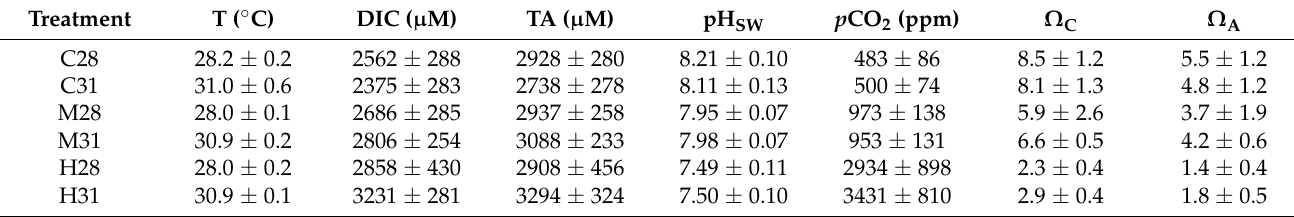
Table 1. Mean physical and chemical conditions ± SD in the different treatments of elevated p CO 2 (C = 492 ppm, M = 963 ppm, H = 3182 ppm) crossed with 28 ◦ C and 31 ◦ C. Temperature = T, dissolved organic carbon = DIC, total alkalinity = TA, pH on seawater scale = pH SW , p CO 2 of gas in equilibrium with seawater = p CO 2 , calcite saturation state = Ω Ω C , and aragonite saturation state = A . Additional data on water conditions are provided in Table S1.